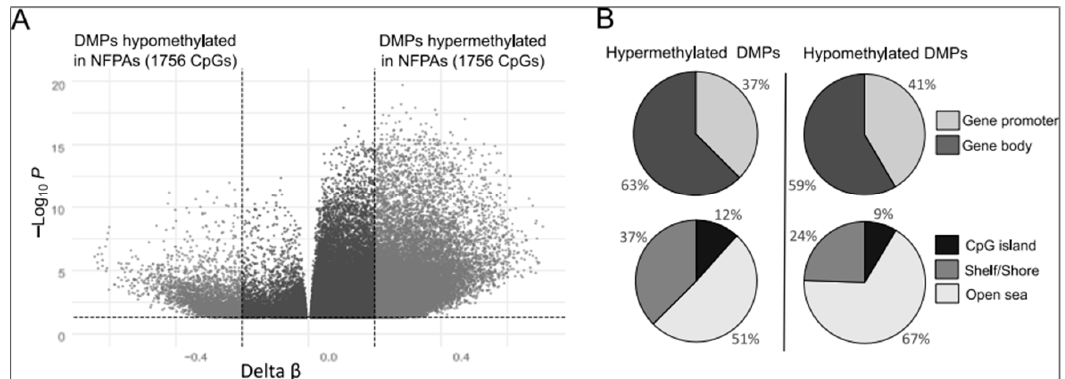
Figure 1. Distribution of gene-associated CpGs that were differentially methylated in gonadotroph nonfunctioning pituitary adenomas (NFPAs) and normal pituitary. ( A ) Volcano plots of differentially methylated CpG sites. ( B ) Differences in the proportions of aberrantly methylated CpGs, stratified according to gene position (5’ promoter including TSS1500, TSS200, 5’UTR, and first exon and gene body/3’ UTR), as well as CpG content (CpG island, open sea, and shelf/shore).